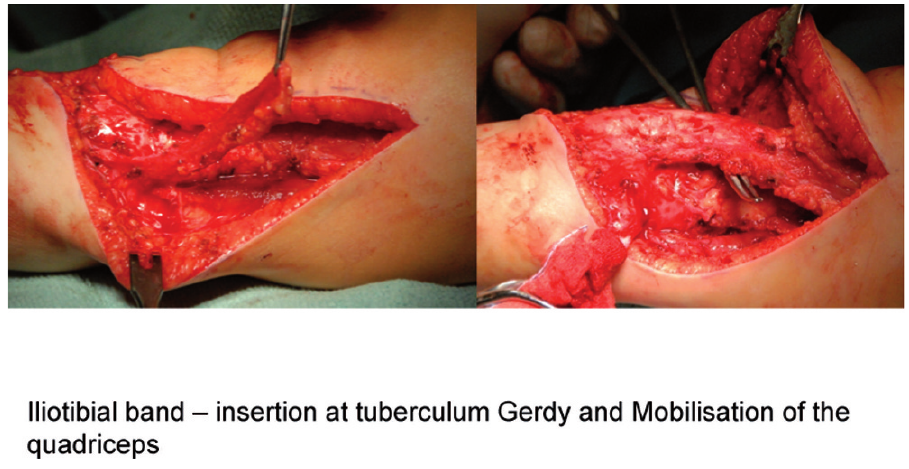
Figure 4 - Iliotibial band – insertion at tuberculum Gerdy and mobilization of the quadriceps.